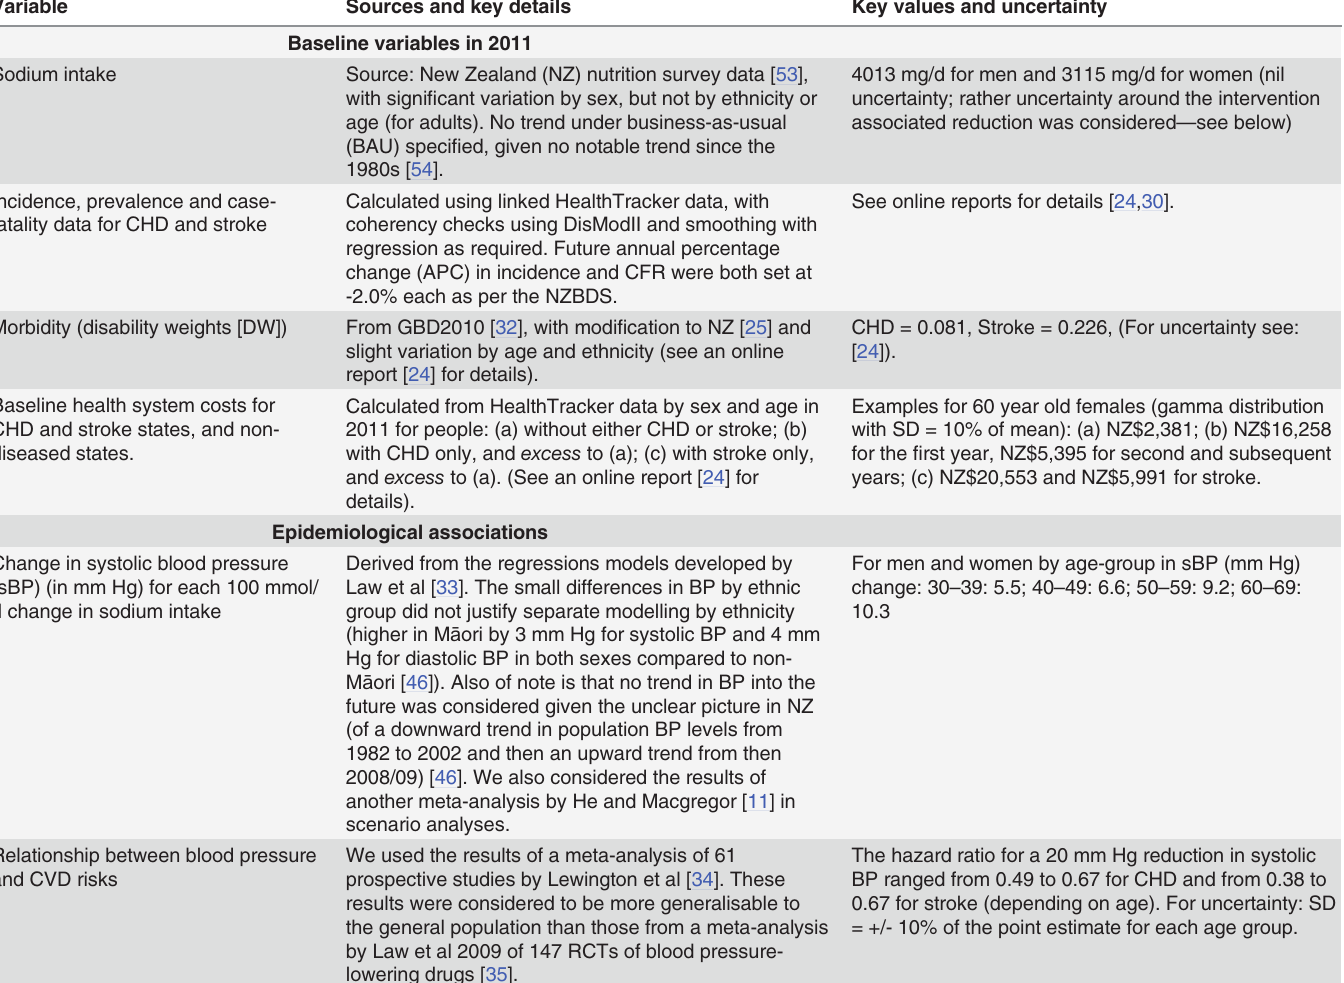
Table 1. Input parameters to the modelling: selected baseline and epidemiological